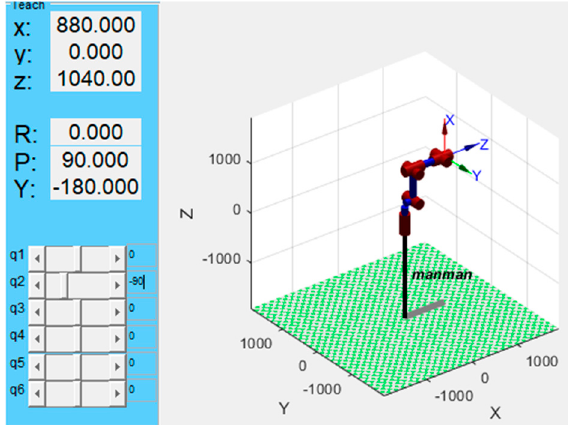
Figure 2. Robot kinematics simulation results.